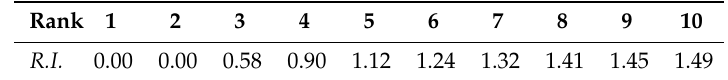
Table 1. Values of random index R.I.